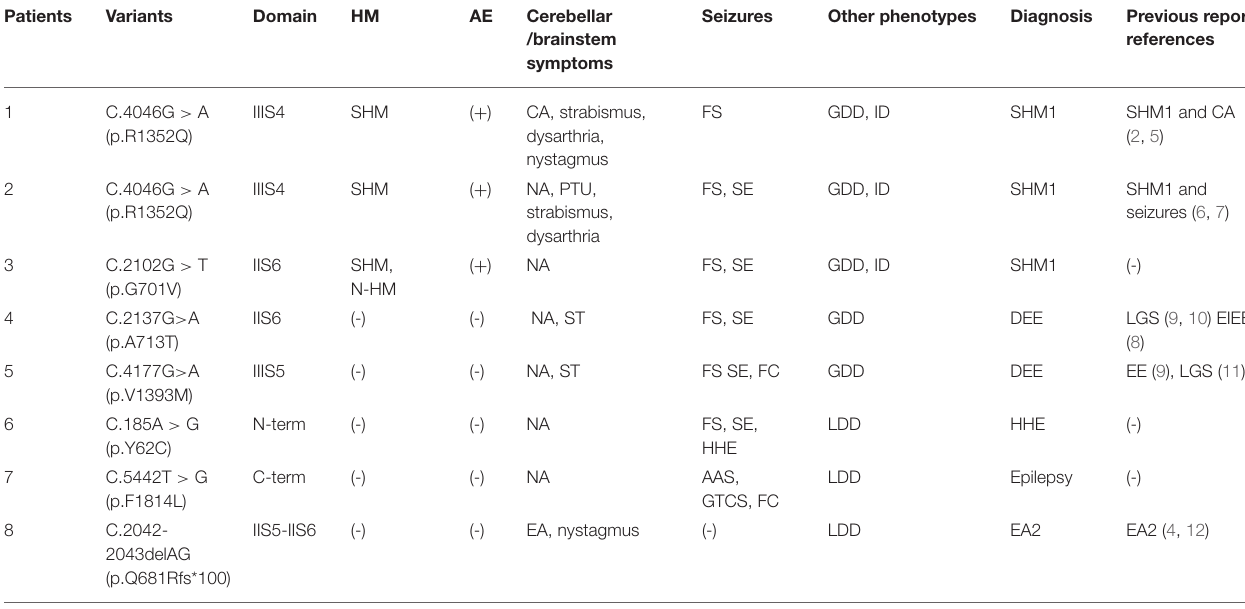
TABLE 1 | CACNA1A gene variants (Genebank transcript ID: NM-000068) and the clinical characteristics.